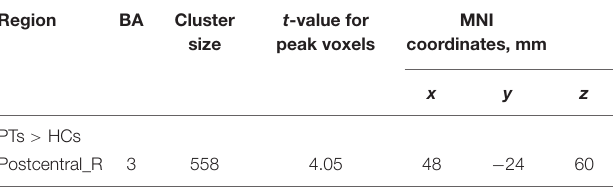
TABLE 2 | Brain regions showing significant ALFF differences between CAI patients and HCs. Region BA Cluster